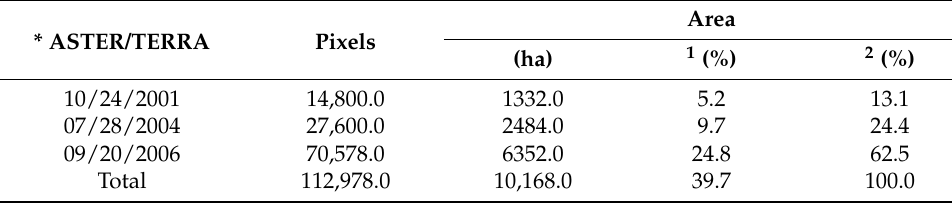
Table 2. Bare soil contributing to each ASTER image of the study area. * ASTER/TERRA